Question: Write a single sentence explaining what this figure depicts.
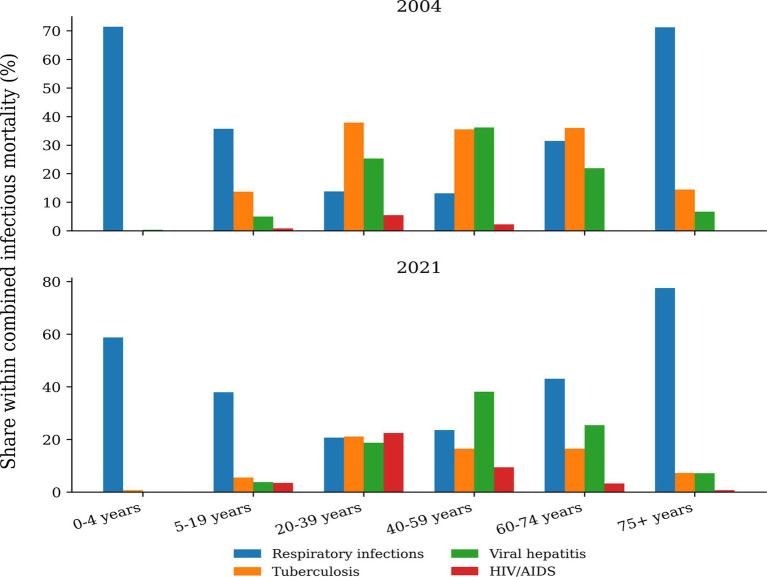
Answer: Cause composition within combined infectious mortality by age group, China, 2004 and 2021. Values are percentages within combined infectious mortality.